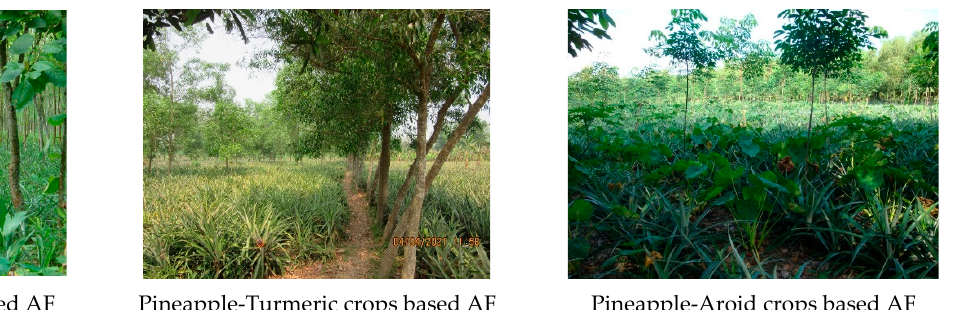
Figure 4. Three most common and profitable agroforestry practices in Madhupur tract, Bangladesh.